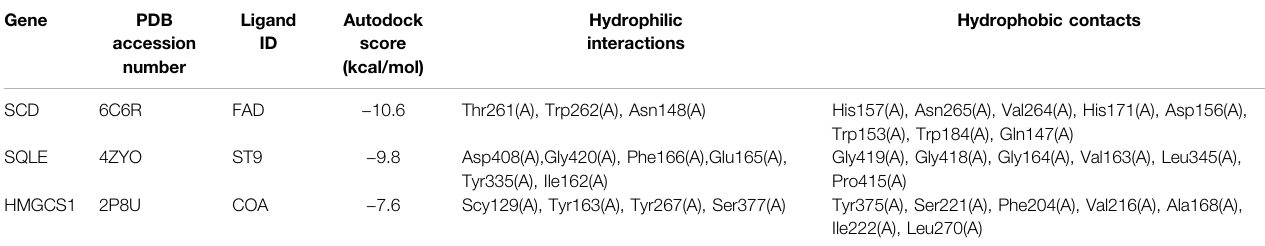
TABLE 2 | The AutoDock Score of putative targets with ellagic acid and the amino acid residue of targets via hydrogen bonds and hydrophobic contact.